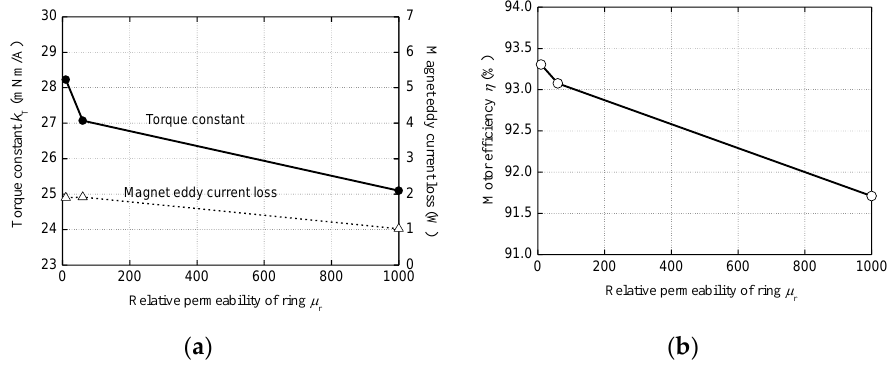
Figure 12. Effect of changing ring thickness ( N = 30,000 rpm, P o = 500 W): ( a ) torque constant and magnet eddy current loss and ( b ) motor efficiency.